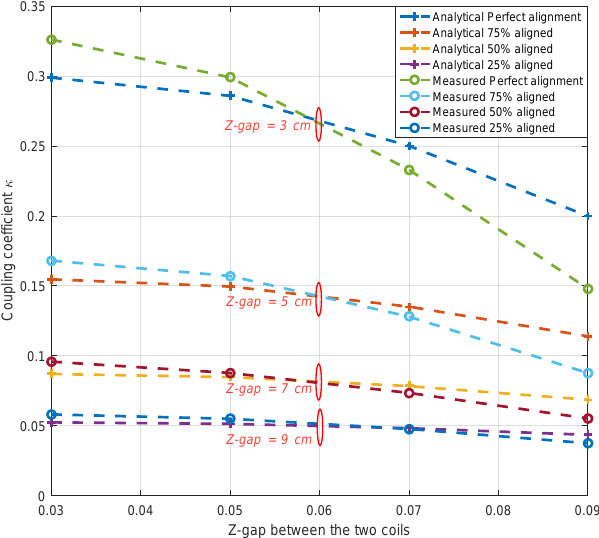
Figure 8. The analytical and experimental comparison of the coupling coefficient of circular coils with z-gaps of 3, 5, 7 and 9 cm with coils of parameters as tabulated in Table